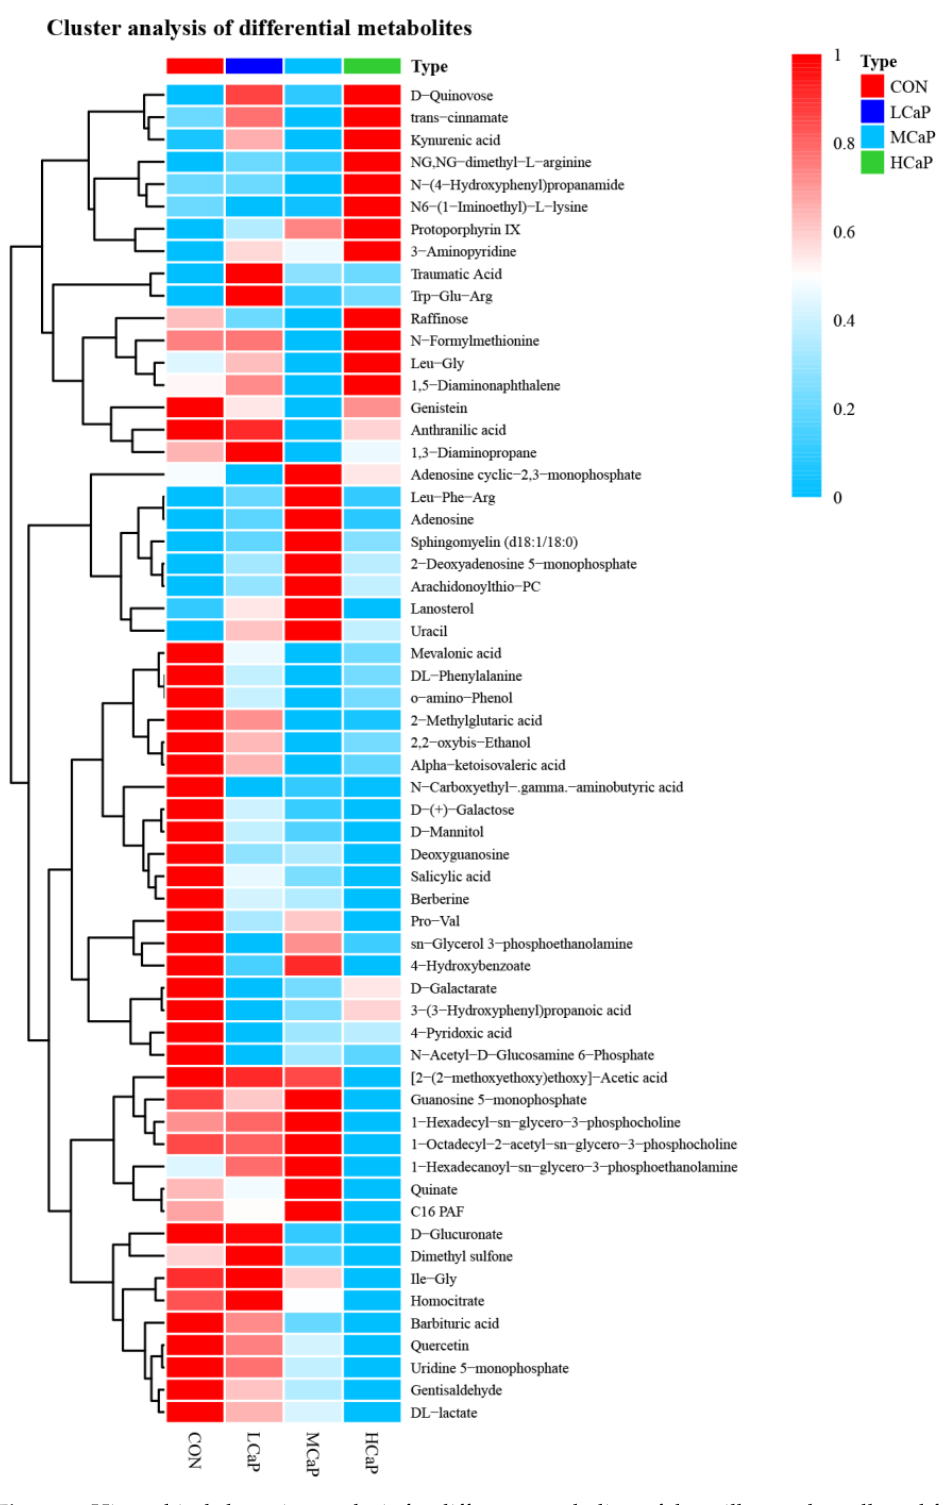
Figure 3. Hierarchical clustering analysis for different metabolites of the milk samples collected from different feeding levels of calcium propionate in early-lactation dairy cows. CON: control group, without calcium propionate addition; LCaP: low calcium propionate, the calcium propionate addition level was 200 g/d per cow; MCaP: medium calcium propionate, the calcium propionate addition level was 350 g/d per cow; HCaP: high calcium propionate, the calcium propionate addition level was 500 g/d per